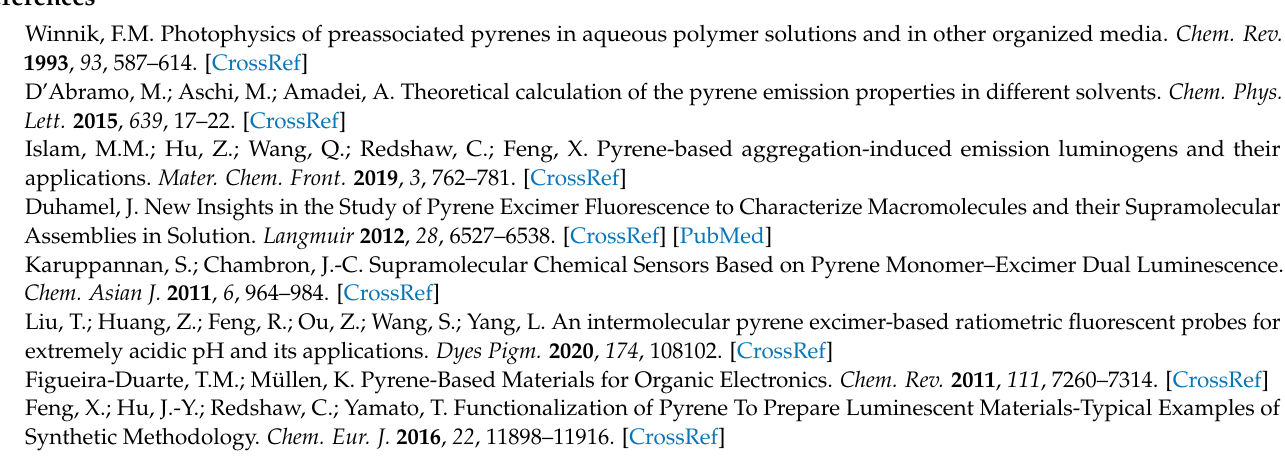
Table S2: Comparison of experimental and theoretical geometries of 3 and 4